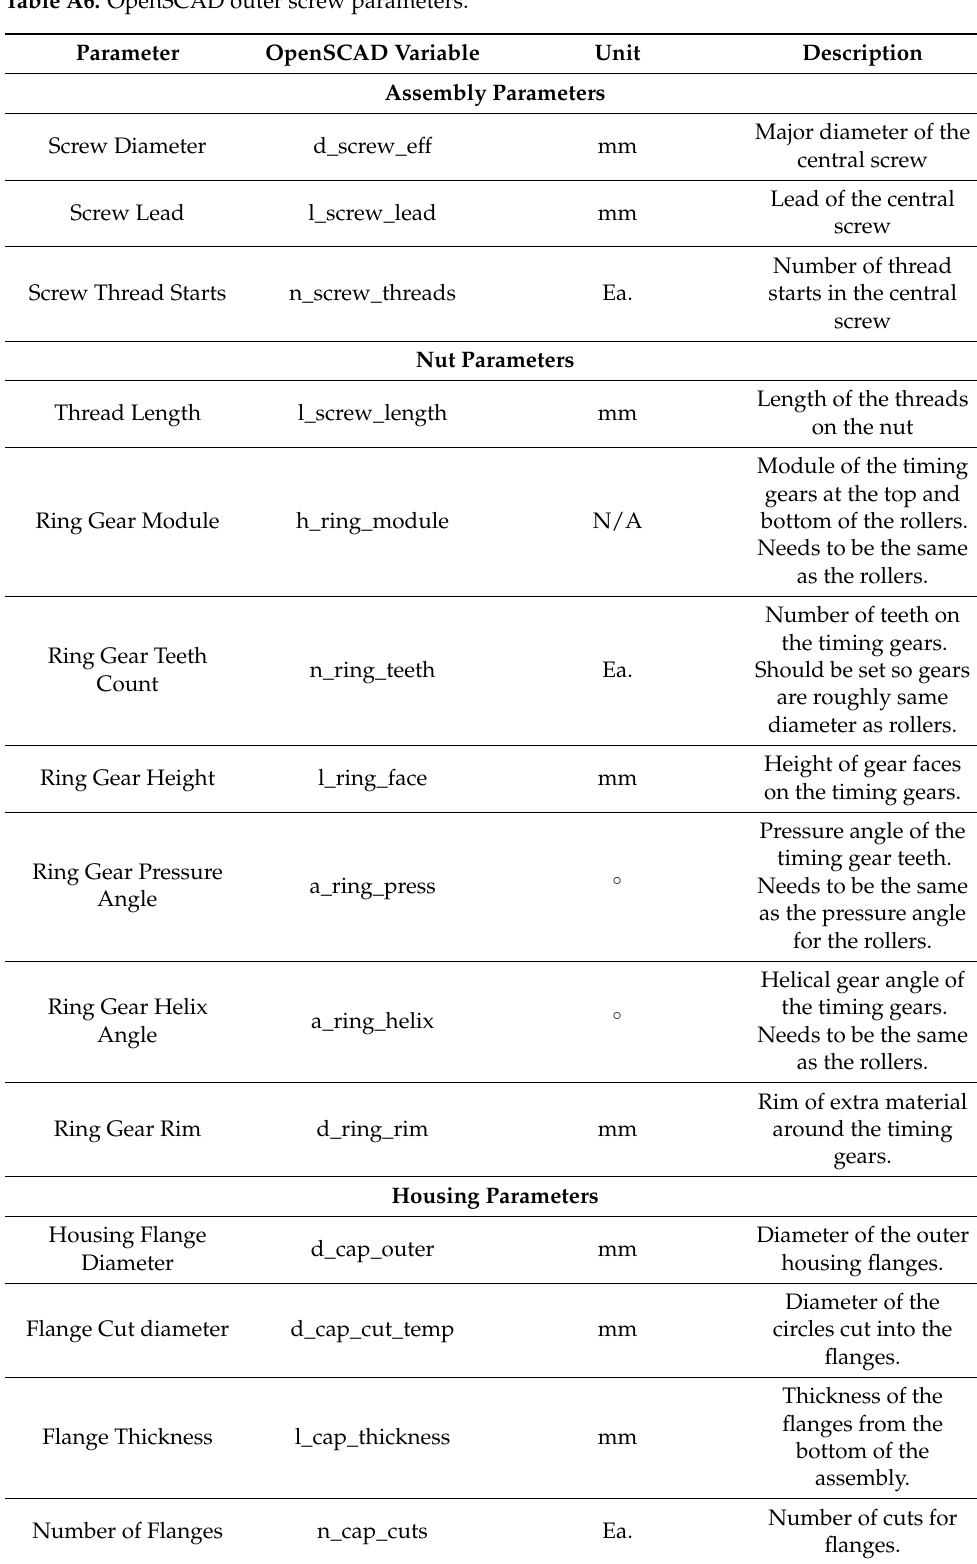
Table A6. OpenSCAD outer screw